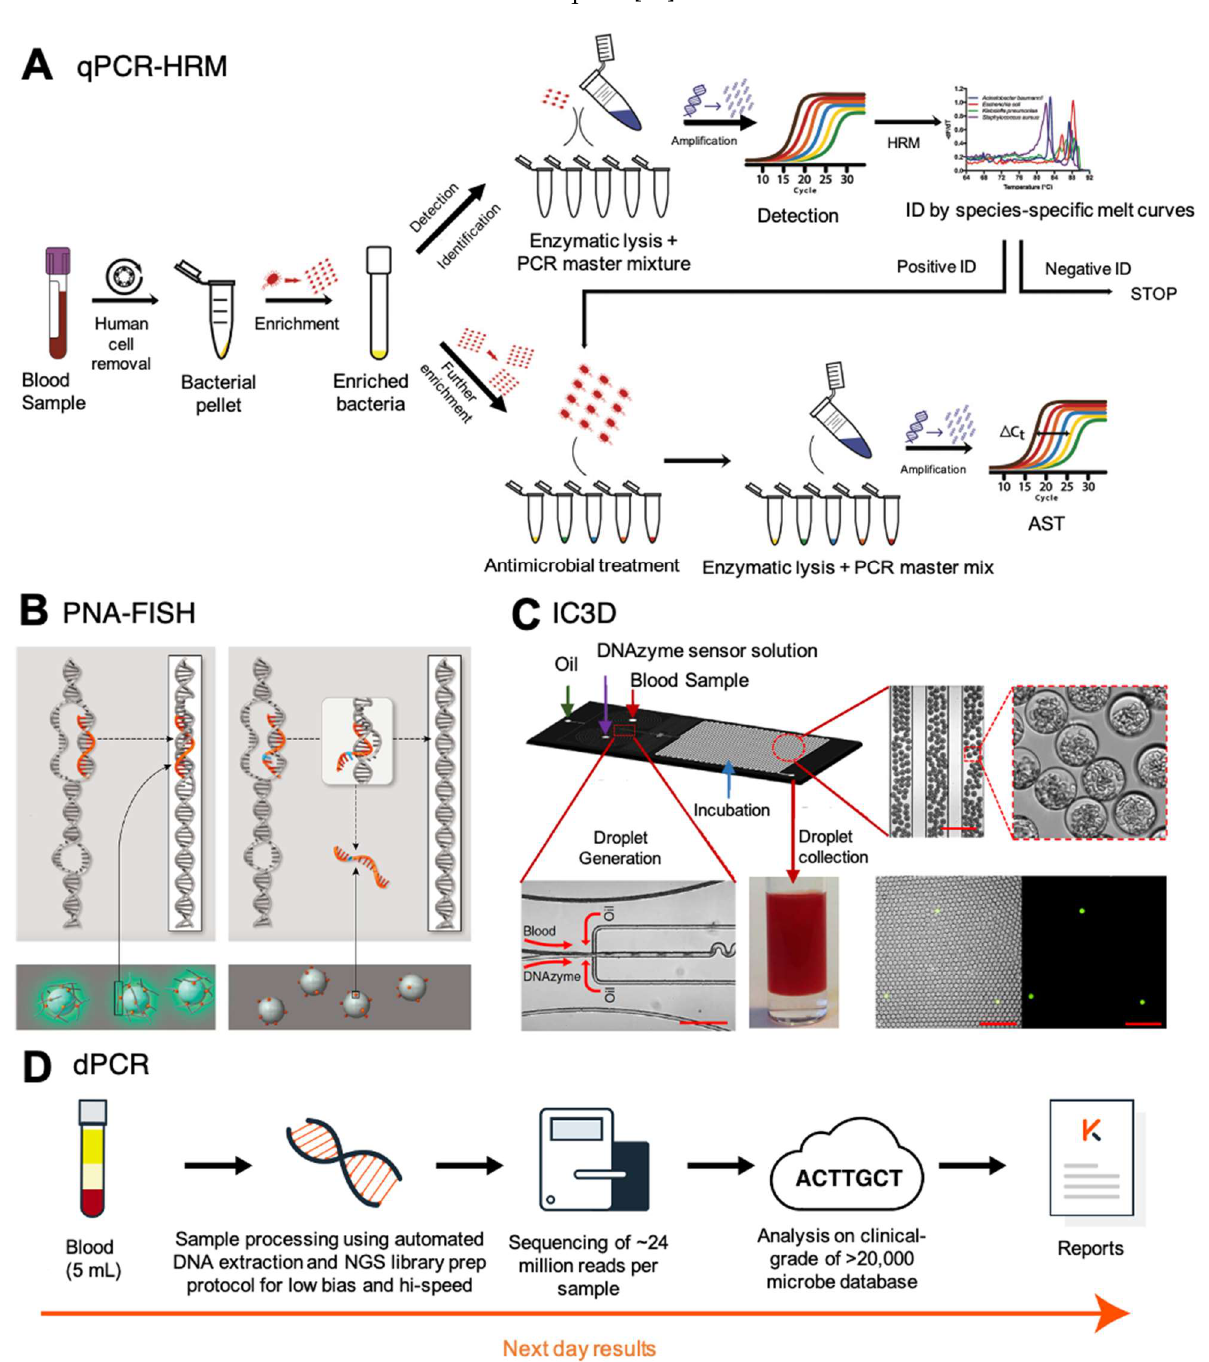
Figure 3. Recent advancements to improve BSI diagnosis. ( A ) qPCR-HRM workflow from a whole blood sample. ( B ) HelixBind PNA-FISH technology with a sequence-specific fluorescence dye, ( C ) Microfluidic-assisted whole blood compartmentalization before DNA amplification and analysis, a trademark of IC3D technology ( D ) NGS detection workflow directly from whole blood by Ka- rius. Figures were modified and used with permission from (Andini et al. 2018; Blauwkamp et al. 2019; D. K. Kang et al. 2014; Nölling et al. 2016).